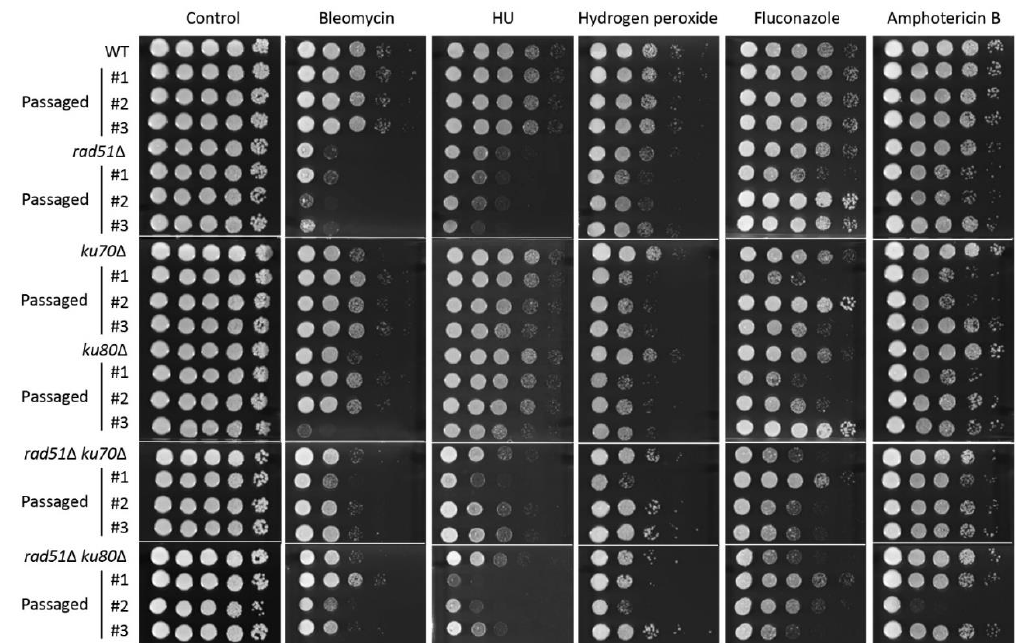
Figure 5. Lack of Rad51-mediated homologous recombination (HR) and KU70/KU80 results in rapid microevolution. The phenotypic changes of original wild-type (WT) strain, rad51 Δ, ku70 Δ, ku80 Δ, rad51 Δ ku70 Δ, and rad51 Δ ku80 Δ mutants compared to those of its corresponding strains after three independent passages (about 600 generations) in response to diverse stress responses. Each strain was cultured in liquid YPD media at 30 °C. The cultured cells were serially diluted (1 to 10 4 ) and spotted on the YPD plate containing stress agents. Cells were further incubated at 30 °C and photographed daily for 3 days. The two images split by a horizontal white line in each spot assay were obtained from the same plate.